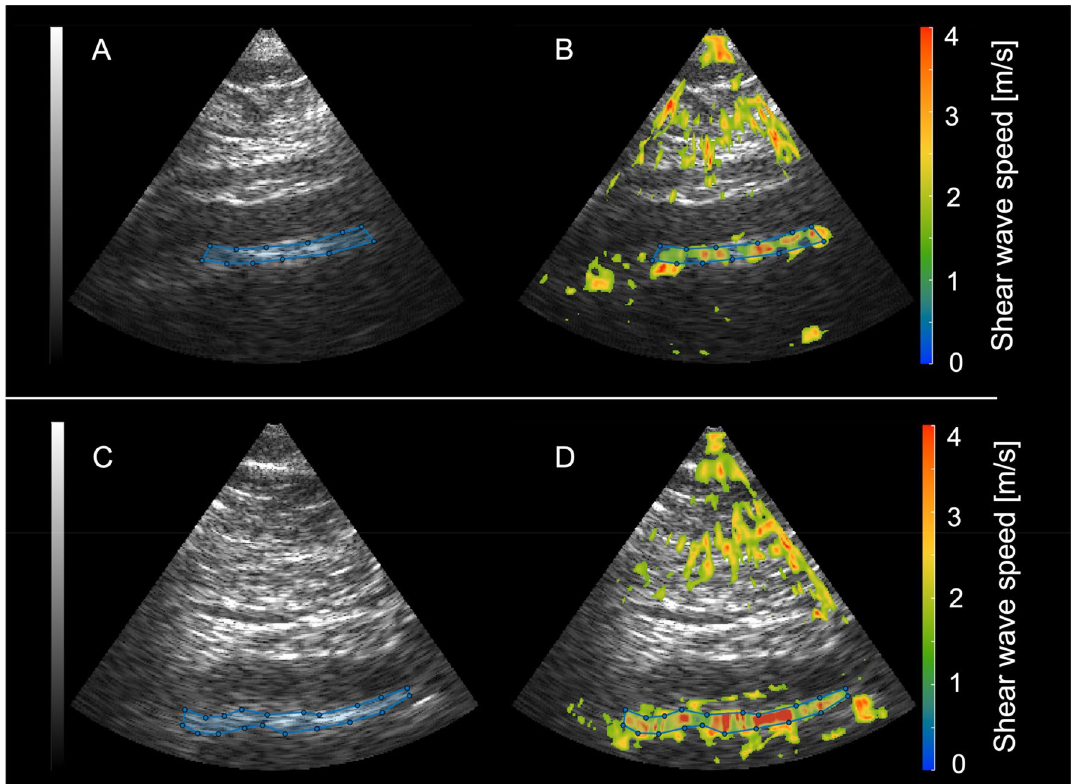
Figure 1. Sagittal B-mode images of the abdominal aorta and corresponding elastograms. The top row shows a sagittal B-mode image of the abdominal aorta ( A ) and the shear wave speed map (measured SWS: 2.77 m/s) ( B ) of a healthy non-smoking volunteer. The bottom row shows the corresponding B-mode image ( C ) and SWS map (measured SWS: 3.03 m/s) ( D ) of an age-matched